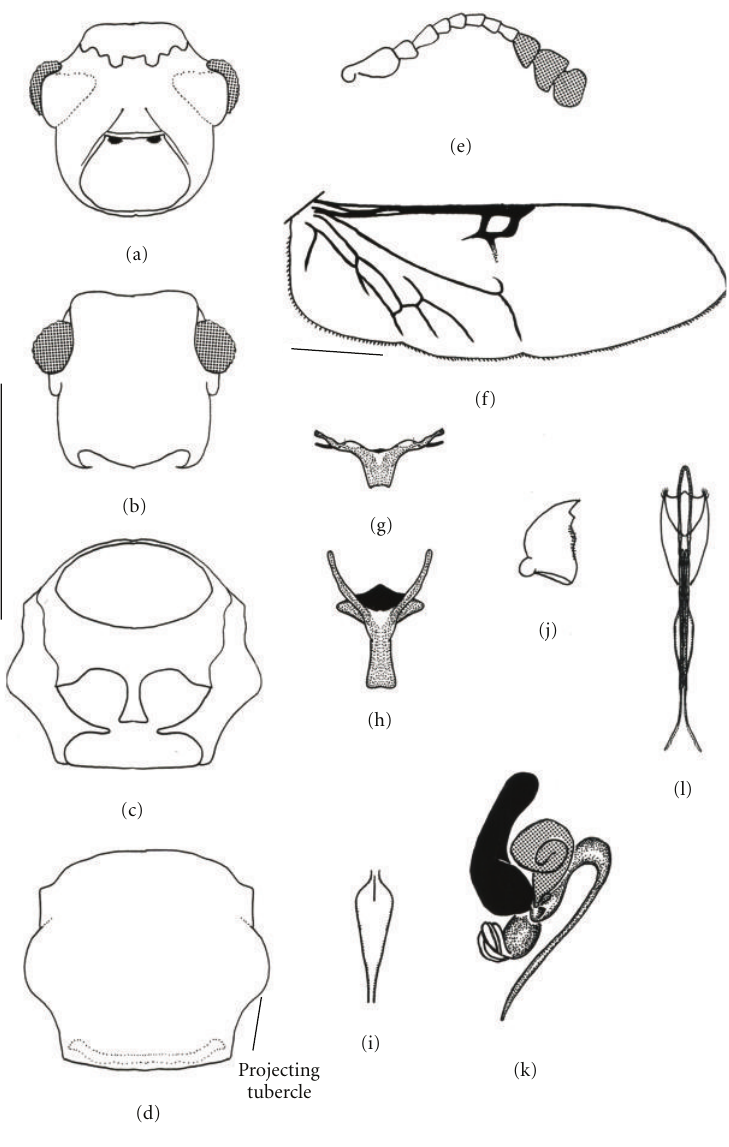
Figure 4: Various organs. (a)–(g) and (h)–(l) of Pseudopylus okei . (a, b) Head ((a) ventral, (b) dorsal). (c, d) Pronotum ((c) ventral, (d) dorsal). (e) Antenna. (f) Metathoracic wing. (g) Metendosternite. (h) Metendosternite of Apopylus unumgarensis . (i) Spiculum. (j) Mandible. (k) Male mesodermal internal reproductive organs. (l)